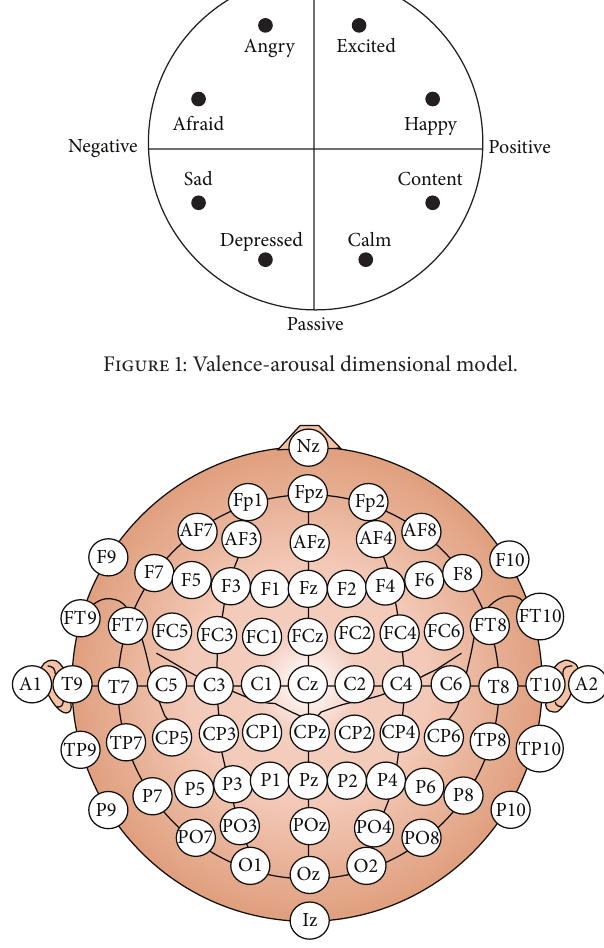
Figure 2: The 10–20 system of electrode placement [3].